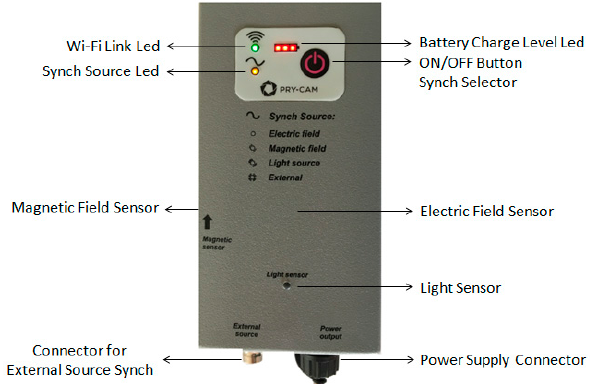
Figure 4. The wireless remote RF synchronizer